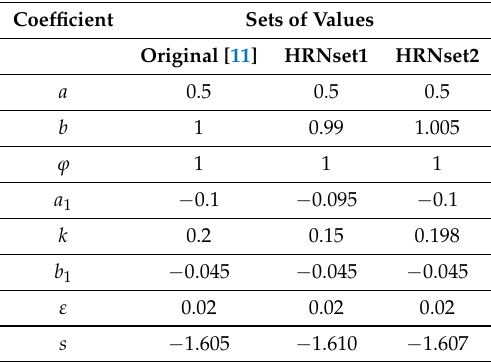
Table 4. Proposed sets of values to generate enhanced chaotic behavior using the Hindmarsh–Rose